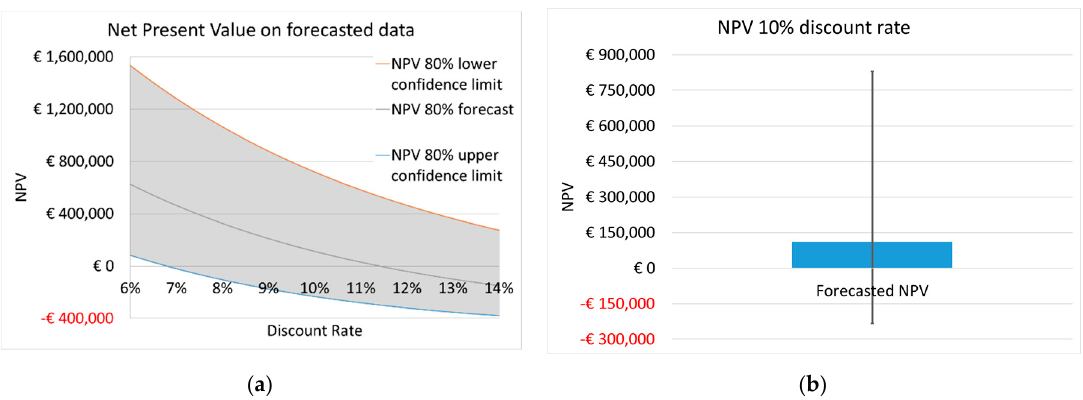
Figure 5. ( a ) Net present value LNG plant with an 80% confidence interval, ( b ) net present value for a discount rate of 10% with the same confidence interval.